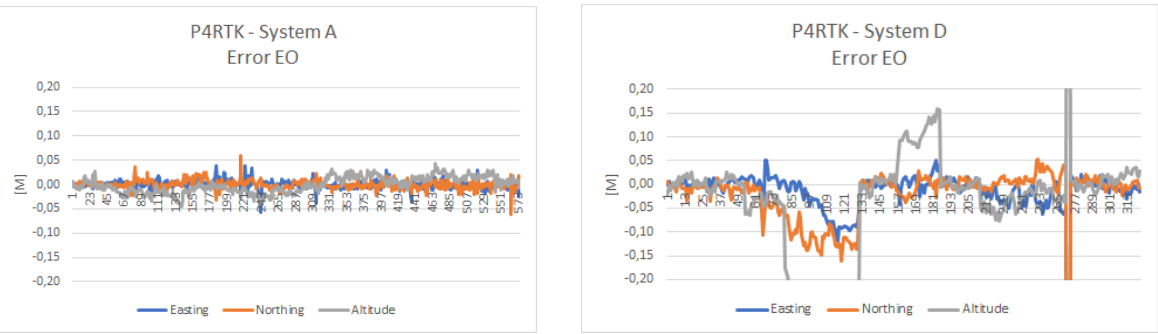
Figure 4. Residuals (Error) at the image positions determined by RTK (EO) after the BBA for the systems A and D